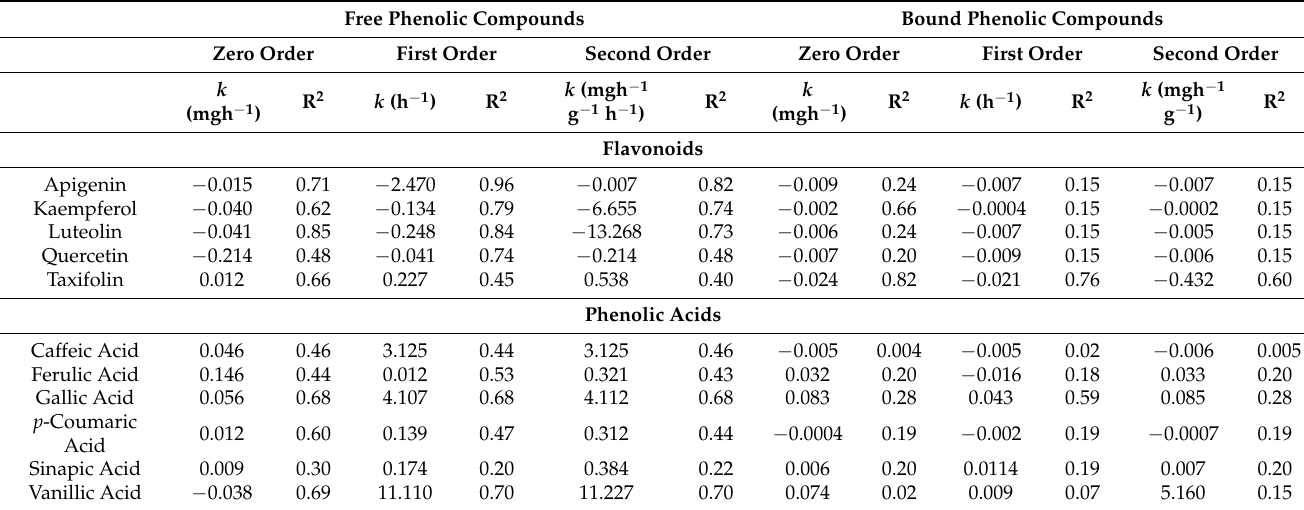
Table 2. Kinetics of phenolic degradation using zero-, first-, and second-order reactions. Free Phenolic